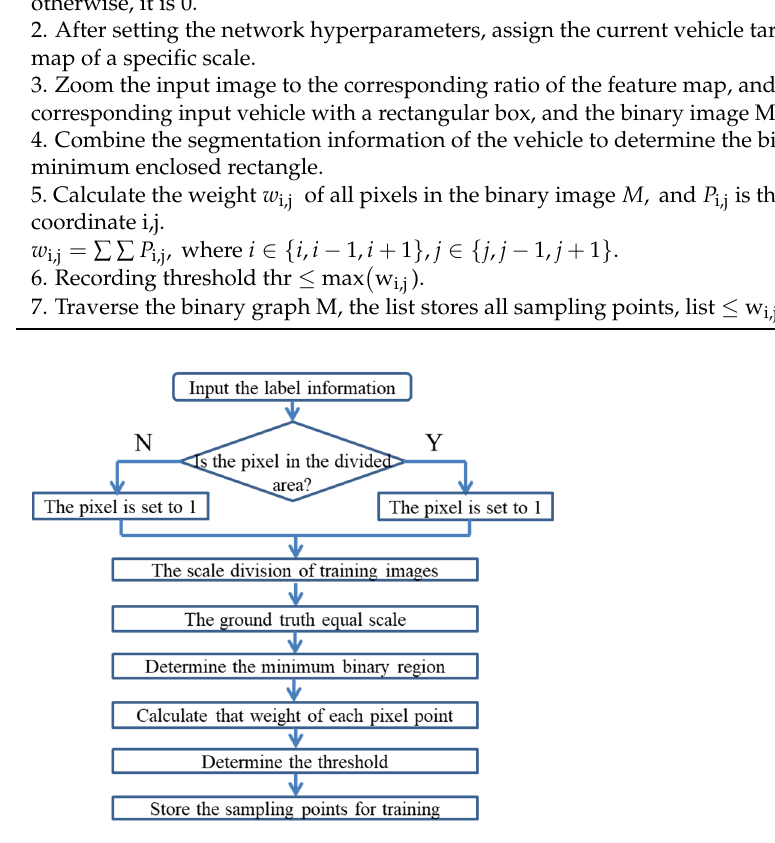
Figure 7. The acquisition process of accurate area point sampling.